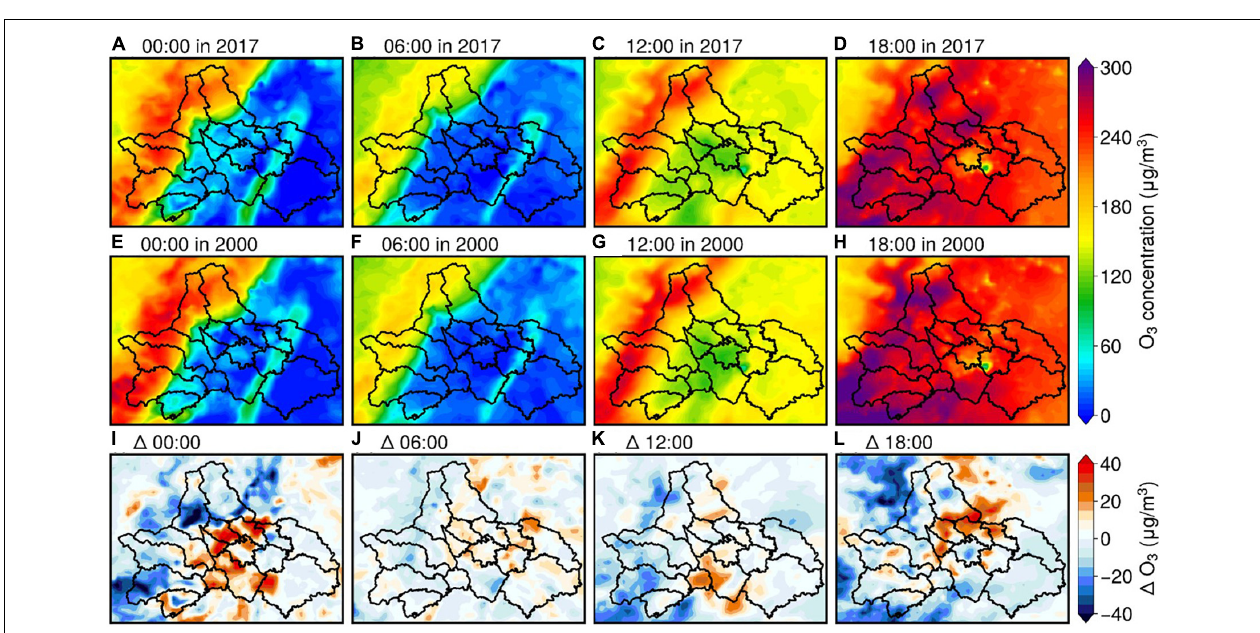
FIGURE 9 | Diurnal pattern of physical and chemical processes for PM 2 . 5 in 2000 and 2017. The average data was calculated from the value of UEA.